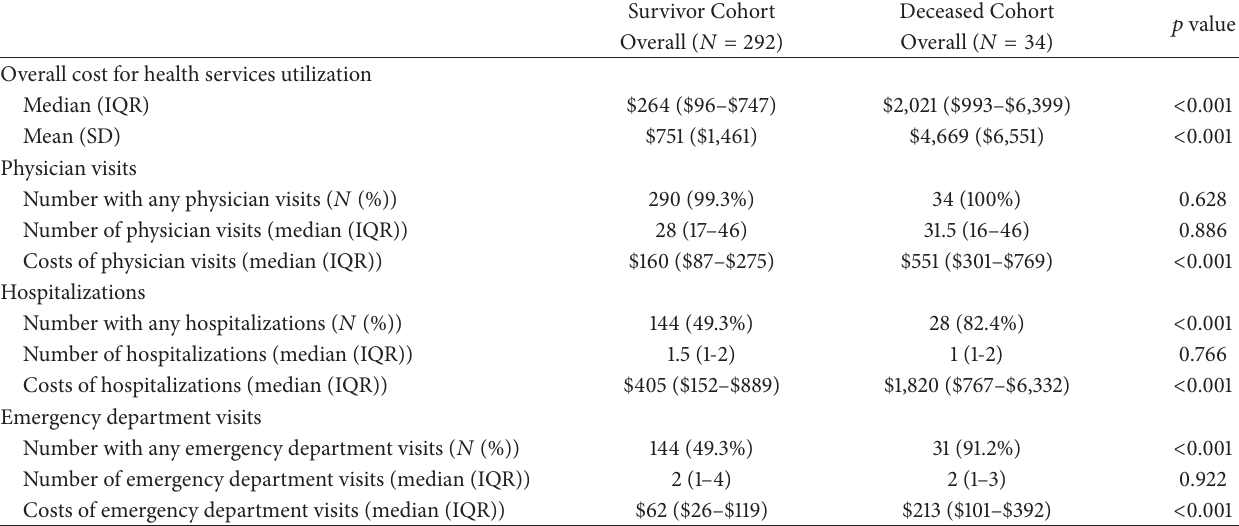
Table 3: Average health service utilization costs per month among individuals receiving PAH therapy in the Survivor Cohort and the Deceased Cohort, in Ontario, from April 1, 2011, to March 31,